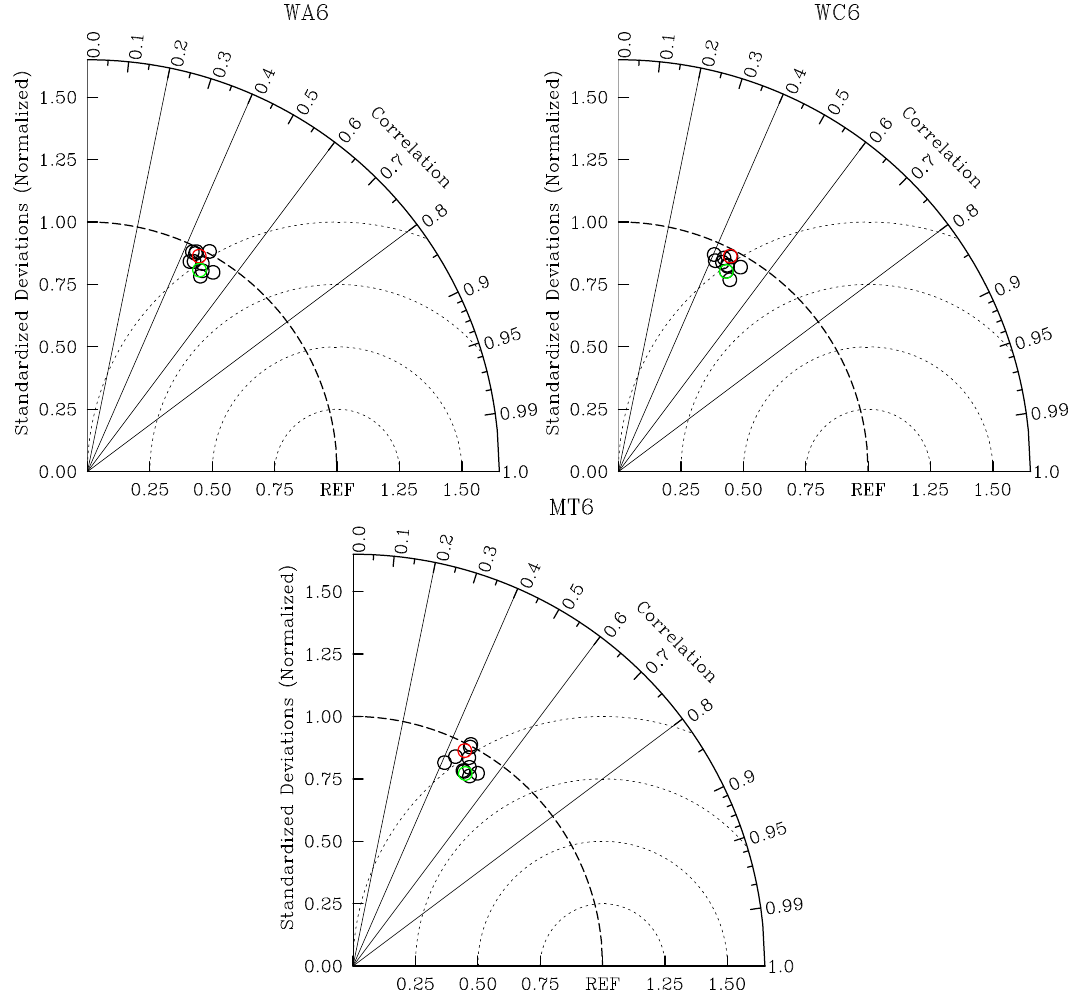
Fig. 7. Same as Fig. 6 except for the WA6, WC6 and MT6 ensembles. The CTRL simulation is given in red, the ensemble members in black and the ensemble mean in green.